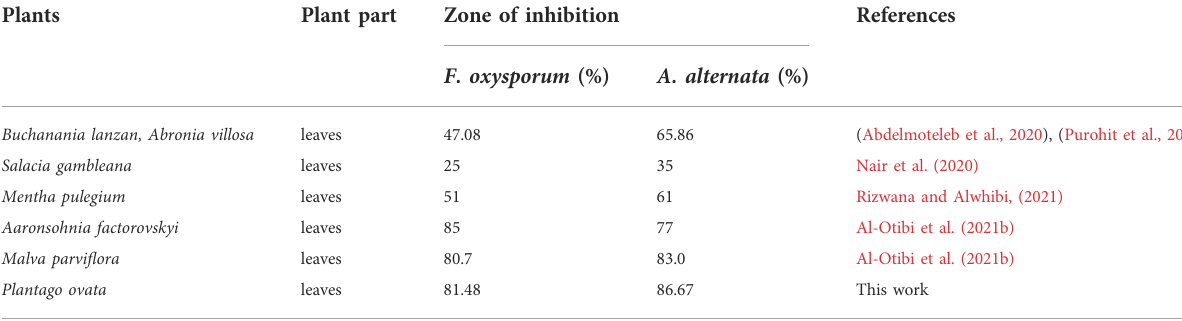
Malva parvi fl ora